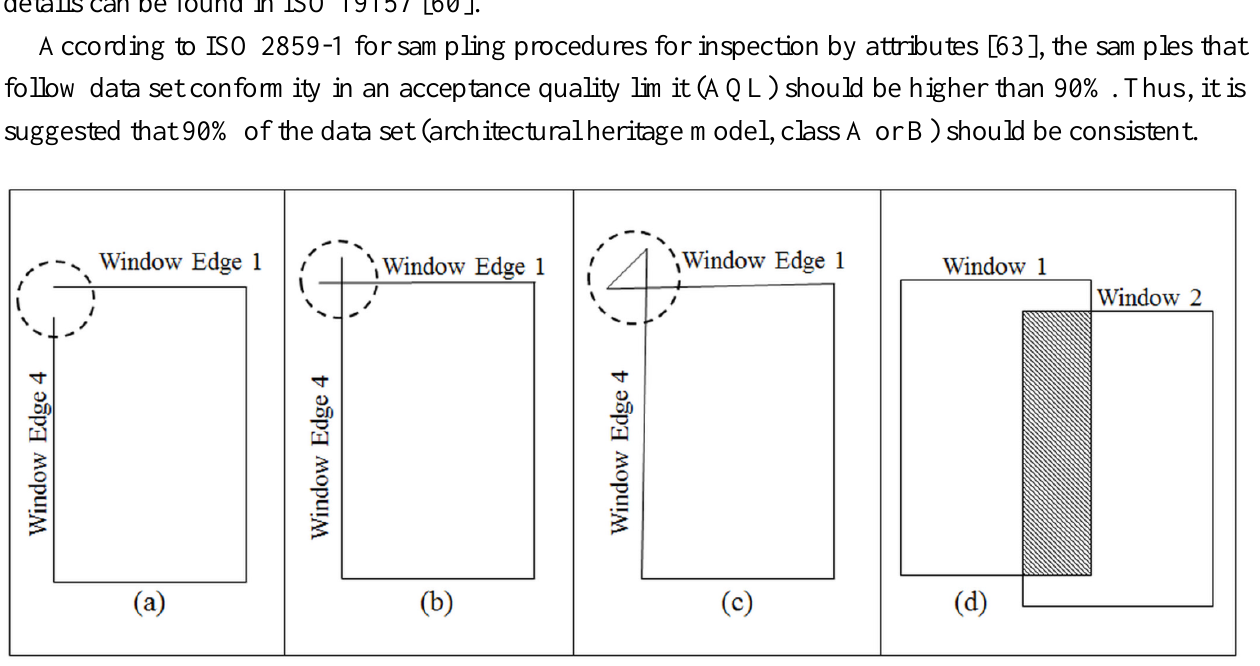
Figure 2. Topological errors examples: ( a ) undershoot, ( b ) overshoot, ( c ) self-intersection, ( d )